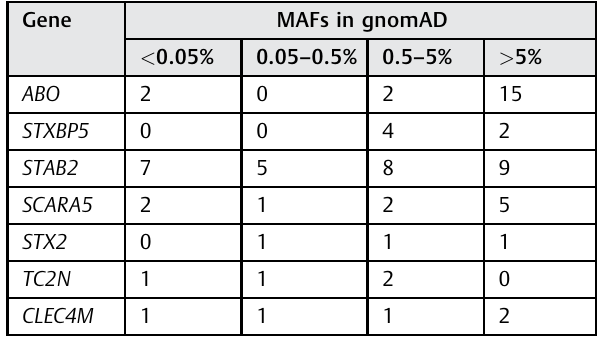
Abbreviations: gnomAD, Genome Aggregation Database; MAF, minor allele frequency. Note: MAFsas reported for thenon-Finnish